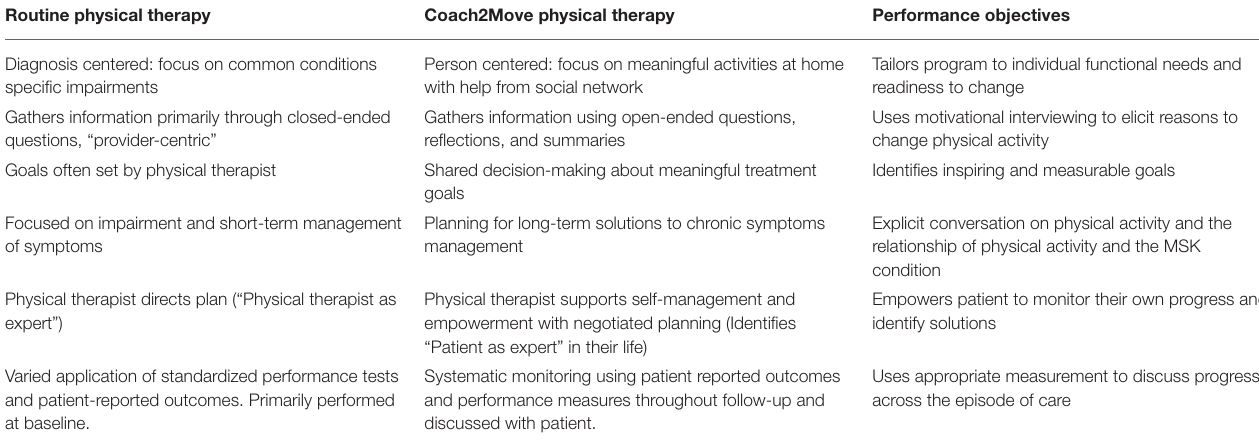
TABLE 1 | Comparison of Coach2Move core components and routine physical therapy. Routine physical